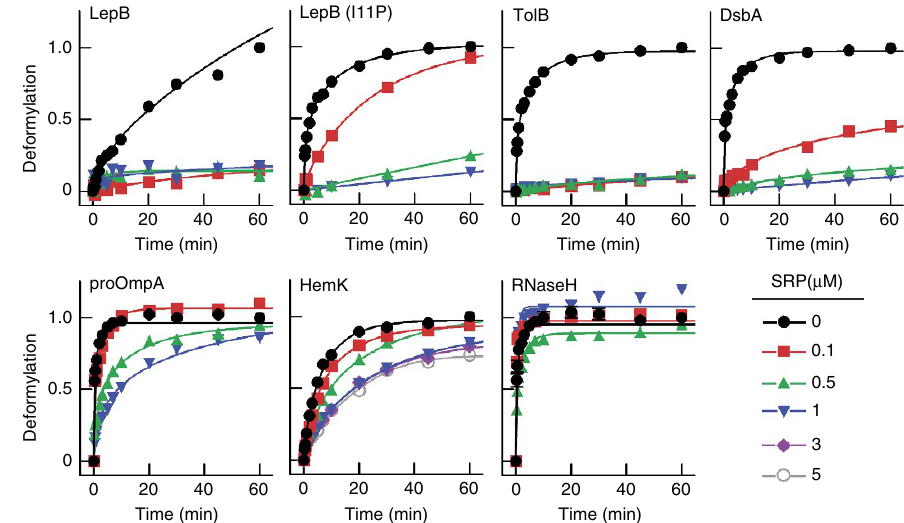
Figure 3 | Effect of SRP on the deformylation of various RNCs. RNCs carrying nascent peptides of 75 amino acids were incubated with PDF in the presence of increasing amounts of SRP. The extent of deformylation over time is normalized to the maximum extent of deformylation after 60min incubation with PDF and no